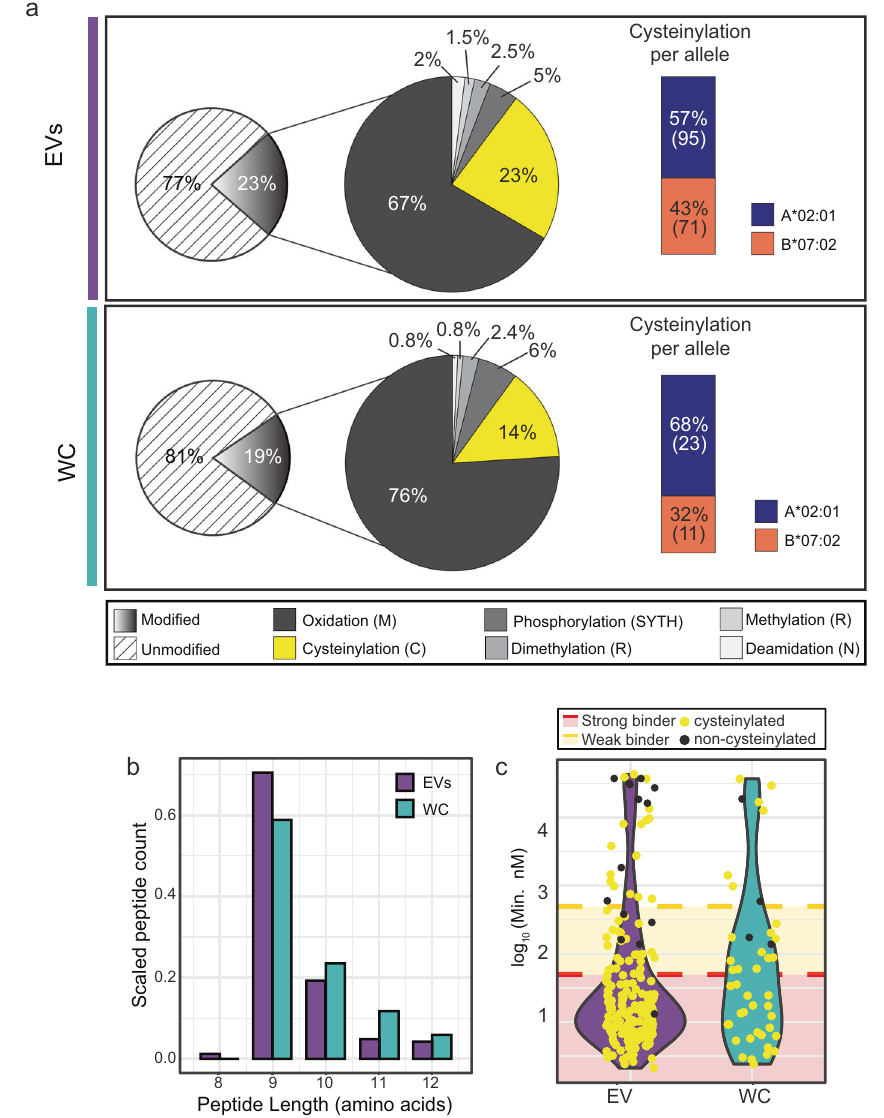
Fig. 4 Post-translational modi fi cation (PTMs) analysis of EV and whole-cell HLA-I peptide ligands. a PTM distribution. EV HLA-I peptide ligands are more frequently cysteinylated than HLA-I peptides from WC. Cysteinylation (yellow) was more abundantly detected on HLA-A binders (blue) than in HLA- B binders (orange). The number of cysteinylated ligands ( n ) derived from each allele is shown in parentheses. b Length distribution of the cysteinylated ligands. Y-axis was scaled to total number of peptides identi fi ed in three technical replicates from either WC or EVs. c Predicted binding af fi nity (nM) of all cysteine-containing peptides. Cysteinylated cysteine-containing peptides (yellow) were predicted to bind more strongly than non-cysteinylated cysteine- containing